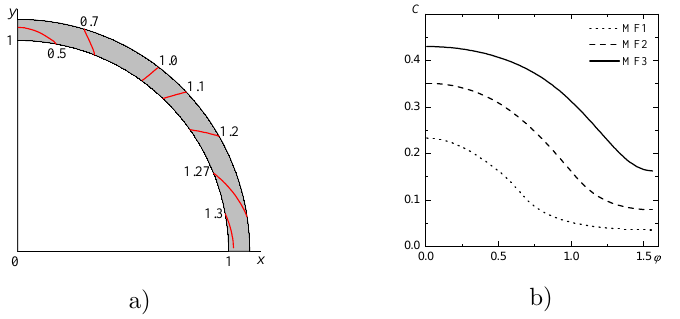
Figure 3. a) Isolines of the dimensionless concentration C/C 0 for the ferrofluid MF3. b) Dependence of the dimensional concentration C versus the polar angle on the center line of the ferrofluid domain at r = (1 + δ ) / 2. Computations are made for model 3 at the dimensionless applied magnetic field intensity h 0 = 10 and at the dimensionless